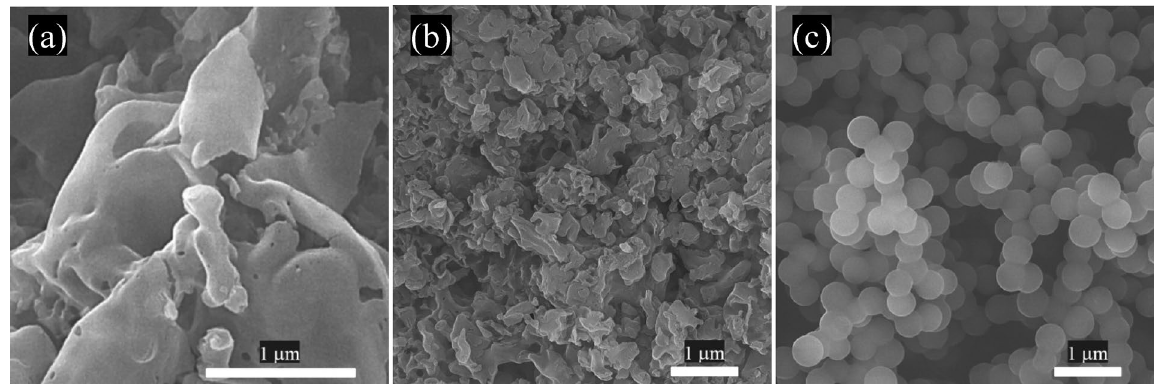
Figure 2. FESEM micrographs of GO ( a ), g-C 3 N 4 ( b ), and CMS ( c